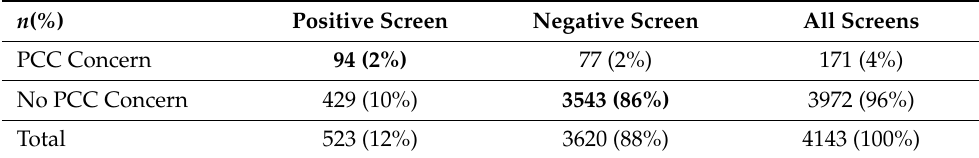
Table 3. Frequencies of PCC Concern and Screening